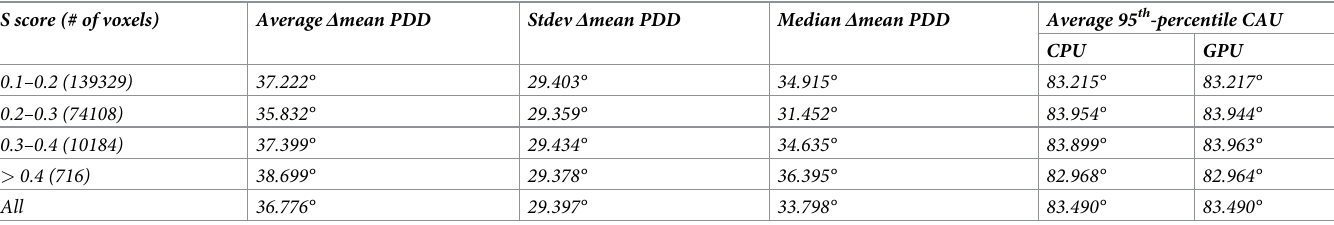
Table 5. Significantly different ϕ 2 , θ 2 .